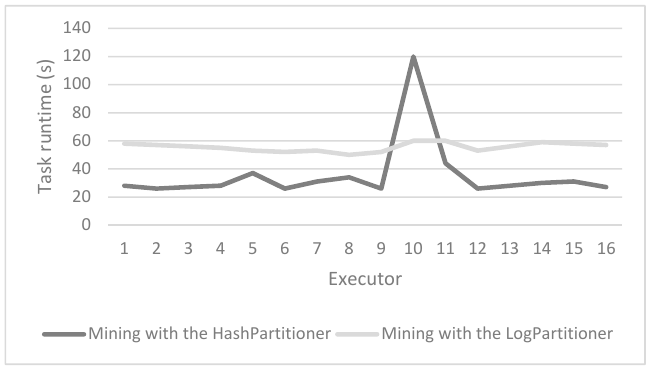
Figure 11. The sum of task runtime on each executor.